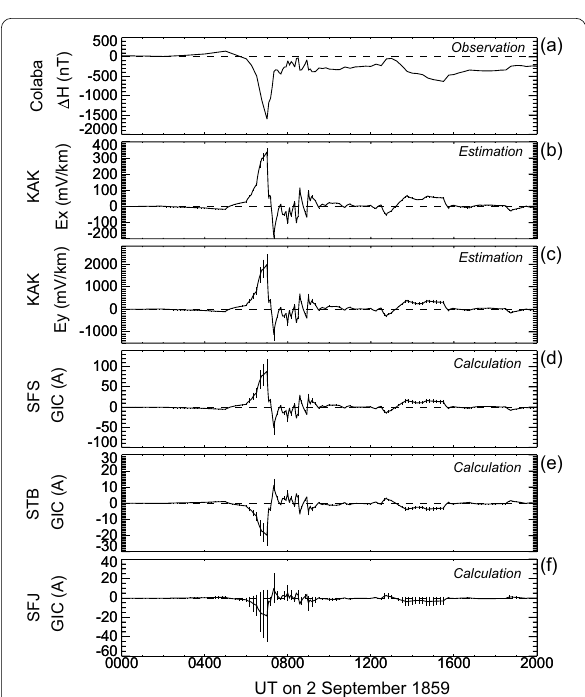
Fig. 5 a Horizontal component of geomagnetic disturbances Δ H at Colaba; b , c estimated geoelectric disturbances E x and E y at Kakioka; d calculated GIC at SFS; e calculated GIC at STB, and f calculated GIC at SFJ. The vertical bars indicate the values that were obtained when we applied 0.9Δ H /2 to Δ D in Eq. ±